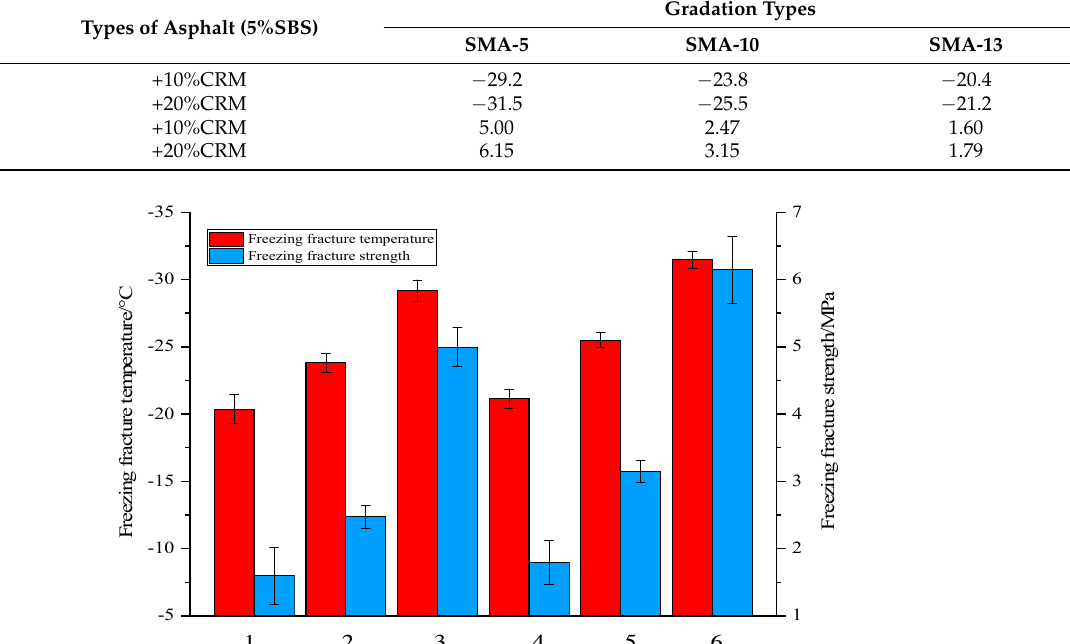
Table 9. Test results of asphalt mixture restraint specimens.